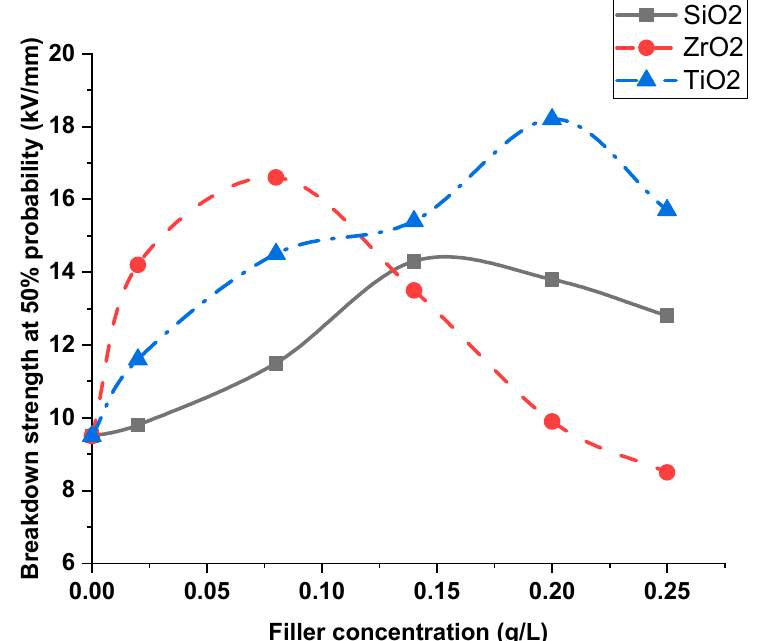
Figure 8. Breakdown strength at 50% probability of transformer oil containing different types of nanoparticles (SiO 2 , ZrO 2 and TiO 2 ).